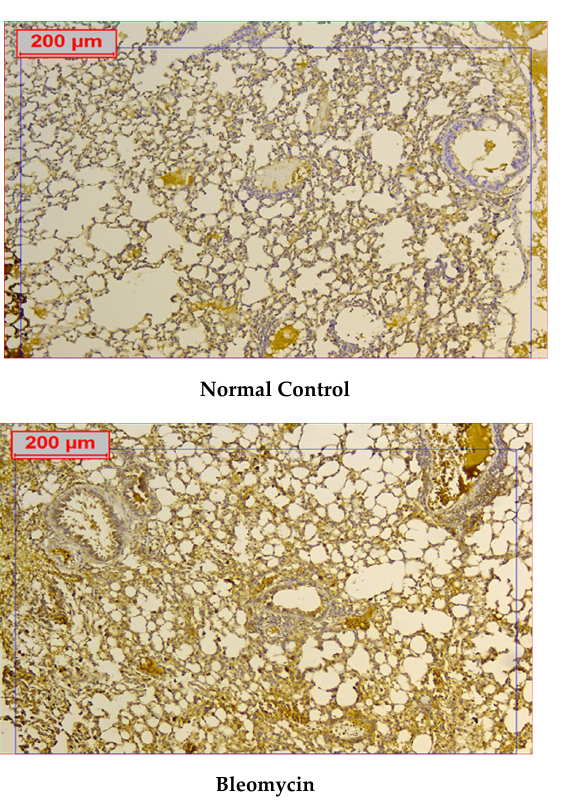
Figure 6. The effect of meleagrin on the protein expression levels of caspase-3 in the lung tissue of the experimental mice determined by immunohistochemistry. Data of the percentage of positive stained area are expressed as mean ± SD and analyzed using one-way ANOVA followed by Bonfer- roni’s post hoc test ( n = 8). * significantly different vs. the normal control group; # significantly dif- ferent vs. the meleagrin group; ^ significantly different vs. the bleomycin group; $ significantly dif- ferent vs. the bleomycin + meleagrin group. Differences were considered significant at p < 0.05.